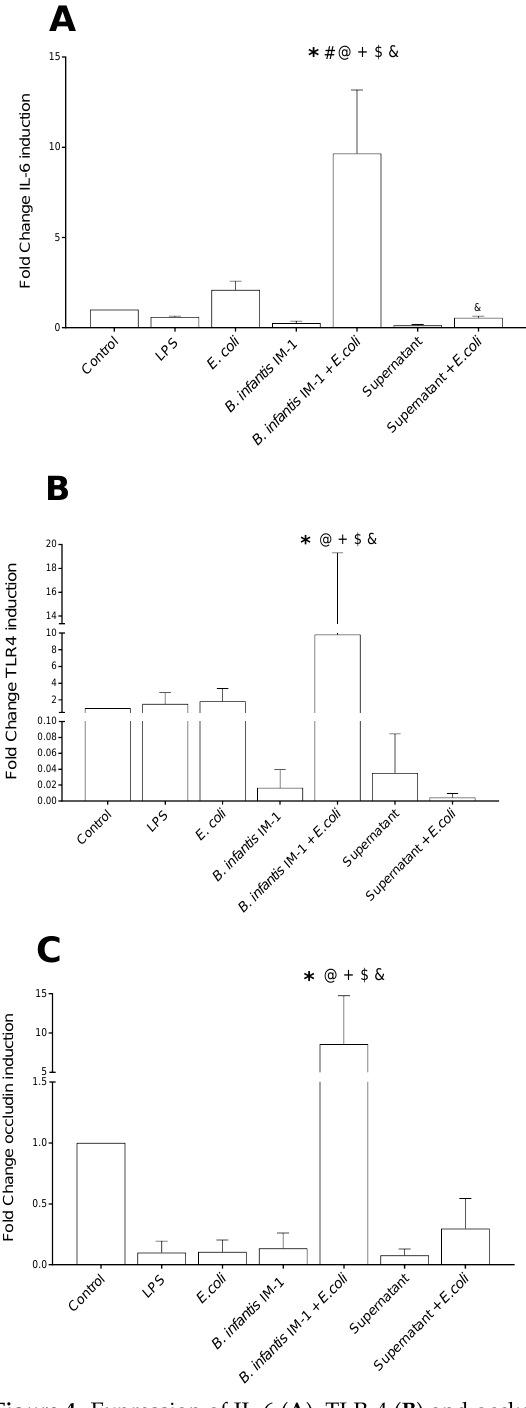
Figure 4. Expression of IL-6 ( A ), TLR-4 ( B ) and occludin ( C ) genes by Caco-2 cells determined by qRT-PCR. Results are expressed as the mean ± SEM of three independent experiments. Changes in gene expression are expressed as fold change versus unstimulated Caco-2 cells. * p < 0.05 vs. control (untreated cells); # p < 0.05 vs. LPS; + p < 0.05 vs. E. coli; $ p < 0.01 vs. B. infantis IM-1 ® ; & p < 0.01 vs. B. infantis IM-1 ® + E.coli ; @ p < 0.001 vs. supernatant. 2.3. B. infantis IM-1 ® and Its Supernatant Reduce the Pro-Inflammatory Response by Co-Cultures of Caco-2 and DCs Unlike the single cultures of Caco-2 cells, in co-cultures of Caco-2 plus DCs, the strongest pro-inflammatory effects in cytokine secretion were observed with LPS and not with E. coli CECT 515 (Figure 5). Treatment of the co-cultures with B. infantis IM-1 ® or its supernatant together with E. coli CECT 515 resulted in reductions in IL- 1β and IFN - γ , compared with the LPS-treated co-cultures (Figure 5A,B). Comparisons with E. coli CECT 515-treated co-cultures did not reach statistical significance. Similar trends were observed for IL-6, IL-8 and TNF- α (Figure 5D– F). No changes whatsoever occurred in TGF- β levels (Figure 6).